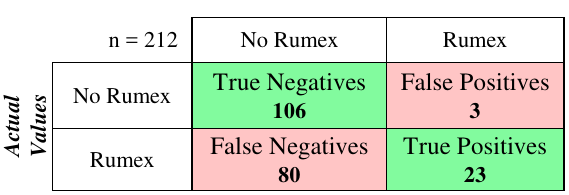
Figure 12. Confusion Matrix - Classification of Rumex partly cut off using the basic trained model.